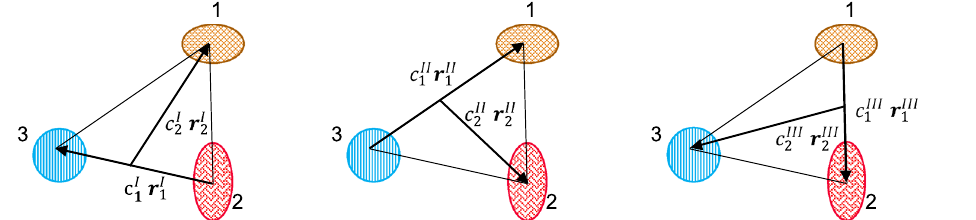
(cid:20) M jk Q = and 1 M j M k –